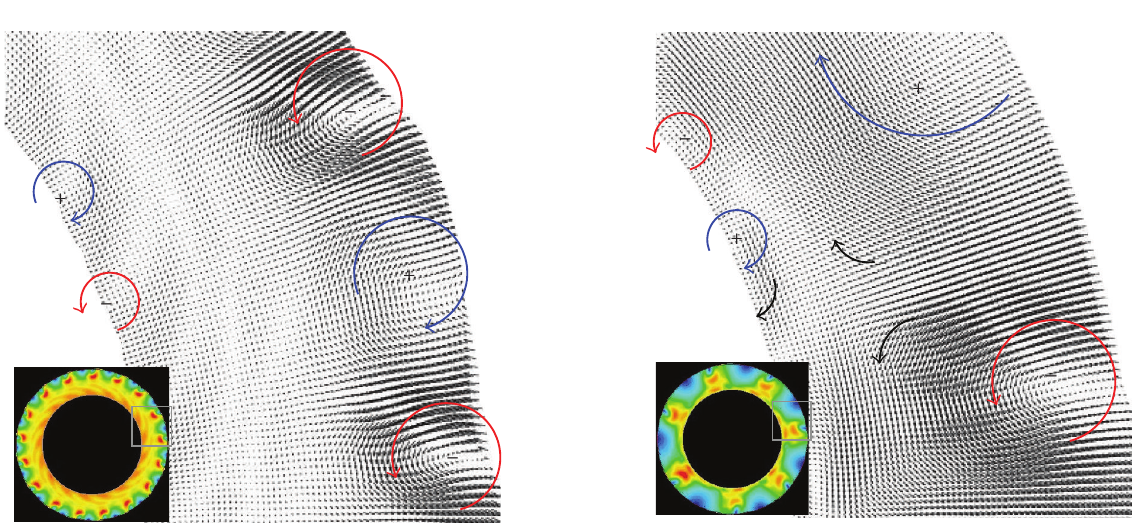
Figure 3: Relative velocity flow field corresponding to the stable operating flow condition.